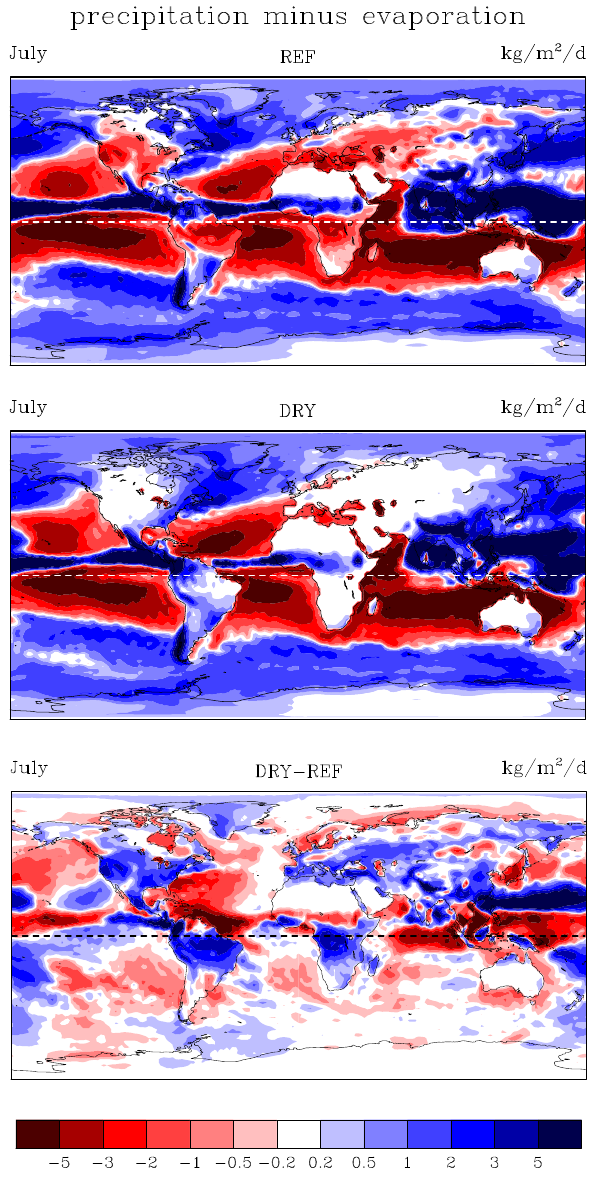
Fig. 9. Precipitation minus evaporation (kgm − 2 d − 1 ) in July in the REF experiment (top panel), in the DRY experiment (middle panel), and the difference between the two (bottom panel). See Fig. S7 in the Supplement for